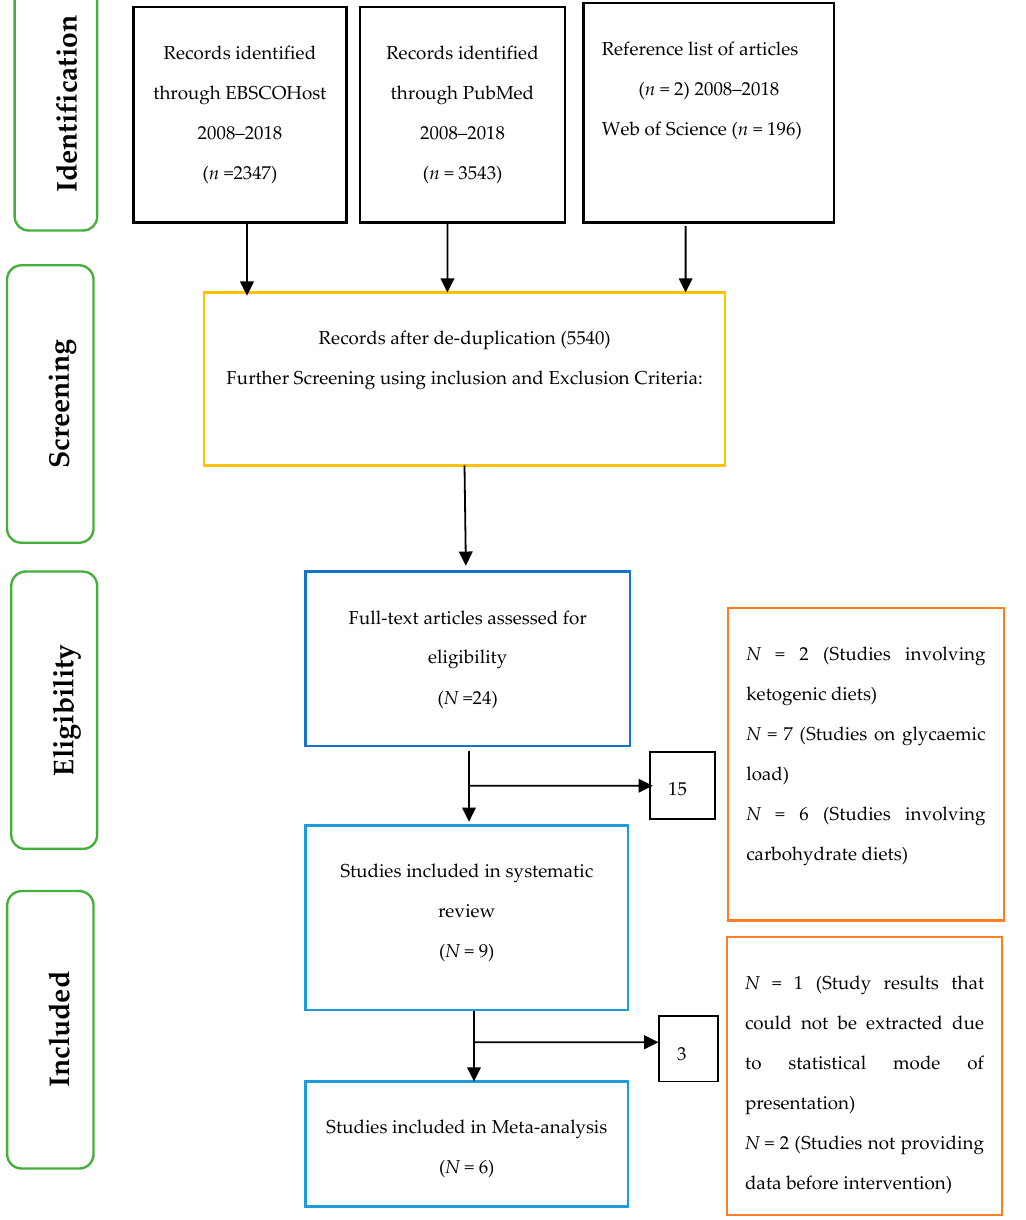
Figure 1. PRISMA flow chart showing the selection of articles.